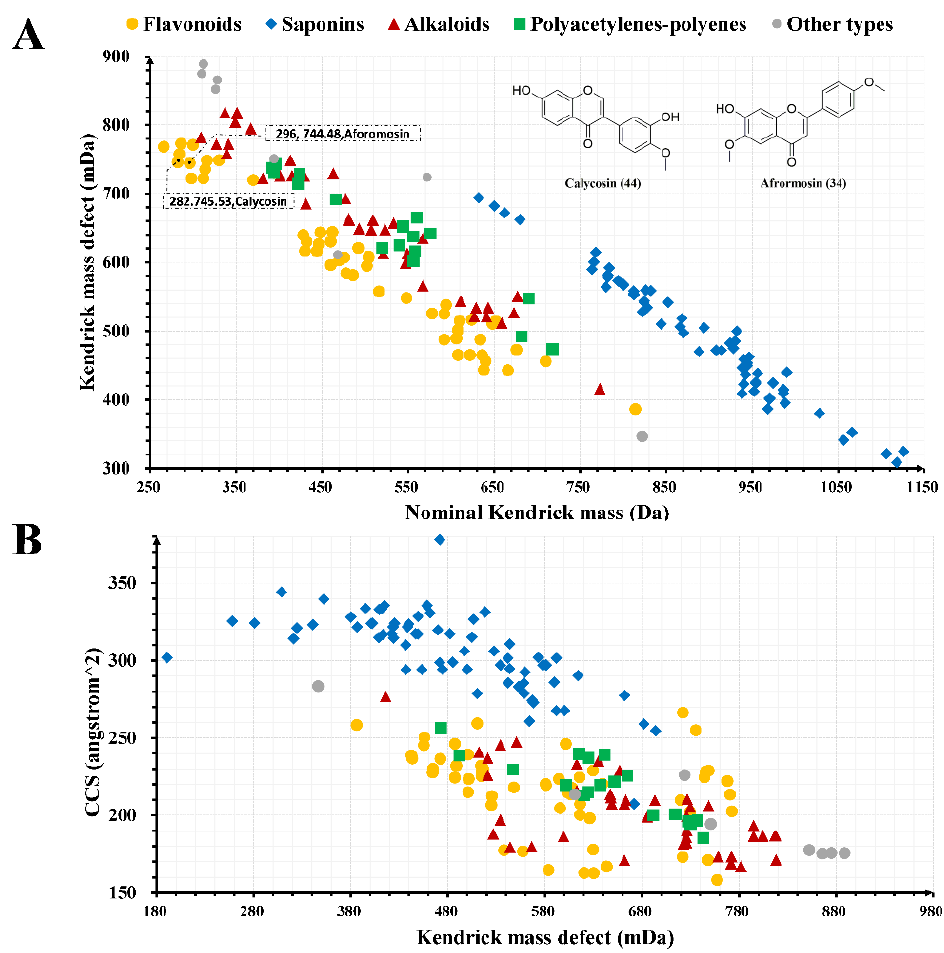
Figure 2. The KMDF scatter plot depicted the m / z values of different types of components in SFI and displayed the relationship between CCS values of various compound types and KMD. (( A ), KMDF scatter plot of different types of chemical components in SFI; ( B ), diagram of different types of components and the CCS values).